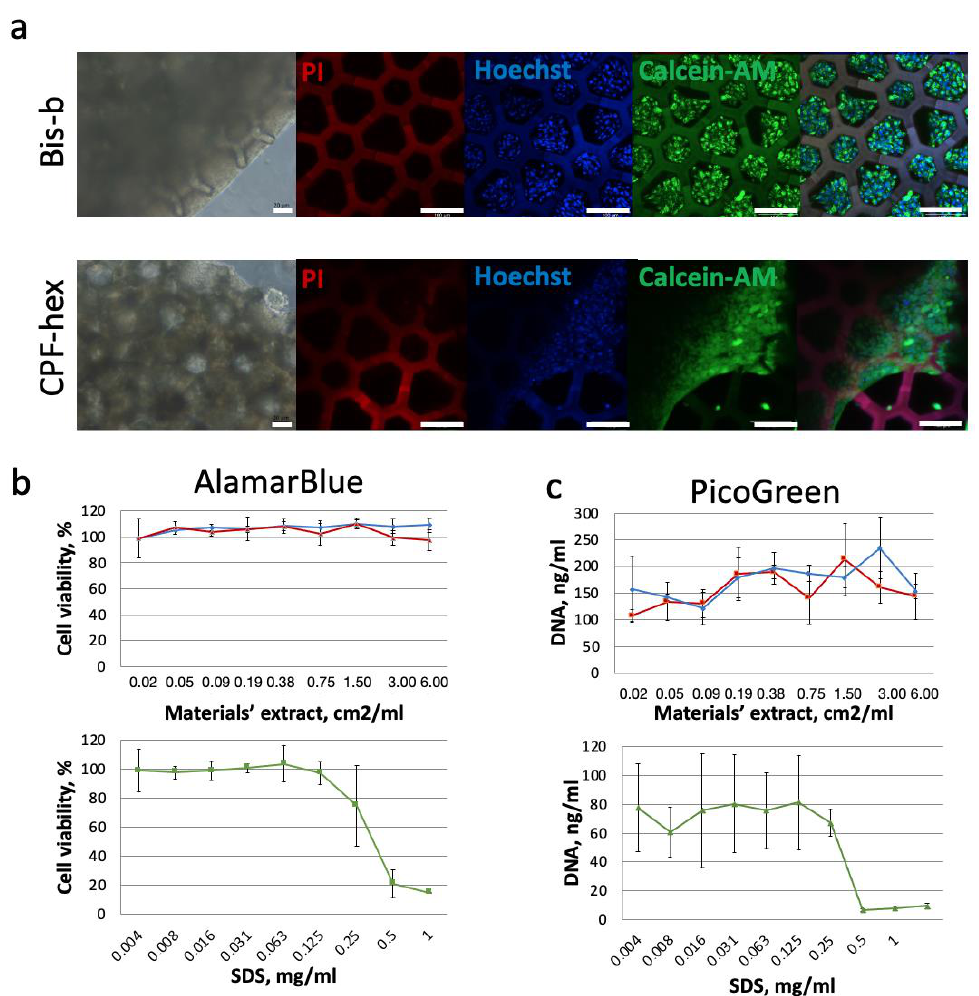
Figure 10. Cytotoxicity of the prepared scaffolds: ( a ) Phase contrast images (scale bar 20 µm) and live/dead staining of the MSC-seeded scaffolds (red — dead cells, blue — cell nuclei, and green — live cells; scale bar 100 µm); ( b ) AlamarBlue and ( c ) PicoGreen assays (blue — CPF-hex, red — Bis-b, and green — SDS (positive control).